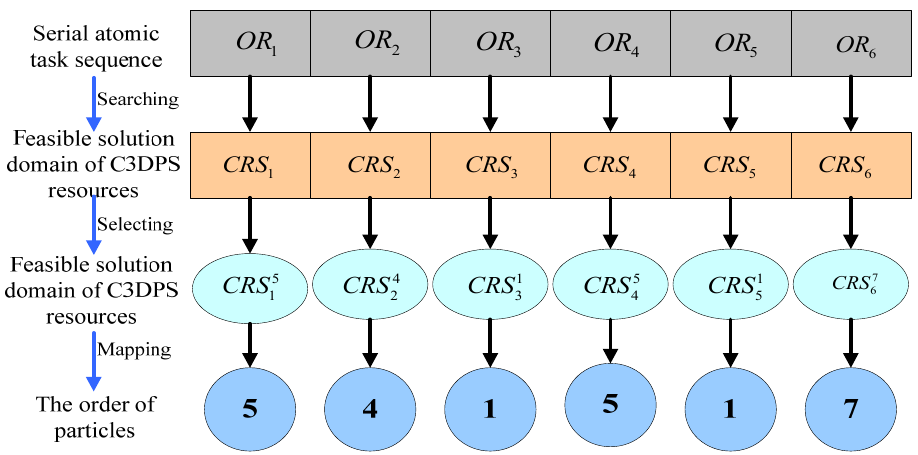
Figure 3. Mapping example of the composition of service resources and particles.